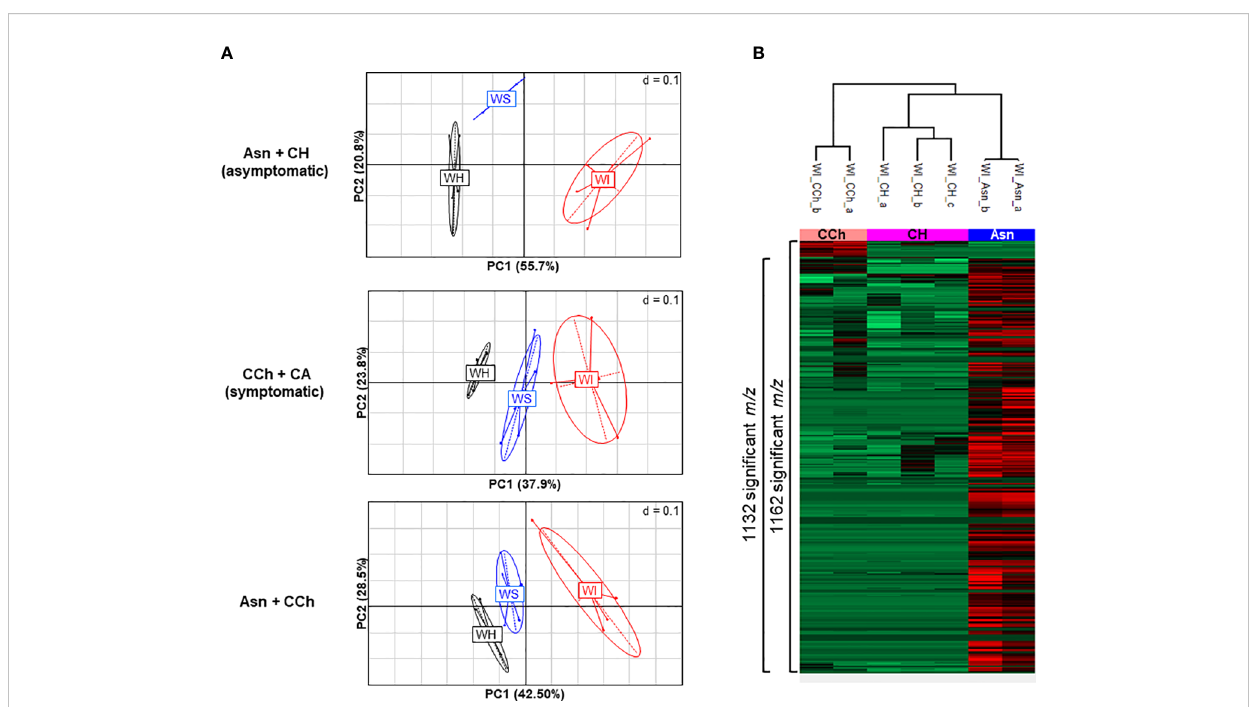
FIGURE 2 (A) PCA illustrations of cross-comparisons of wood samples: asymptomatic Asn+CH (top), symptomatic CCh+CA (middle), and Asn+CCh (bottom). Two to four replicates per wood area (healthy area, WH; streaked area, WS; and interaction zone, WI) per sample group (sodium arsenite-treated, Asn; healthy, CH; symptomatic expressing chronic disease, CCh; and apoplectic, CA). (B) Metabolite variations in wood interaction zone (WI) of signi fi cant 1,173 m/z ( p < 0.05) between healthy (CH), chronic disease form (CCh), and sodium arsenite-treated grapevines (Asn). Numbers of signi fi cant t-test m/z (FDR < 0.05) that discriminate pair-to-pair groups are indicated on the side of the graph. PCA, principal component analysis; FDR, false discovery